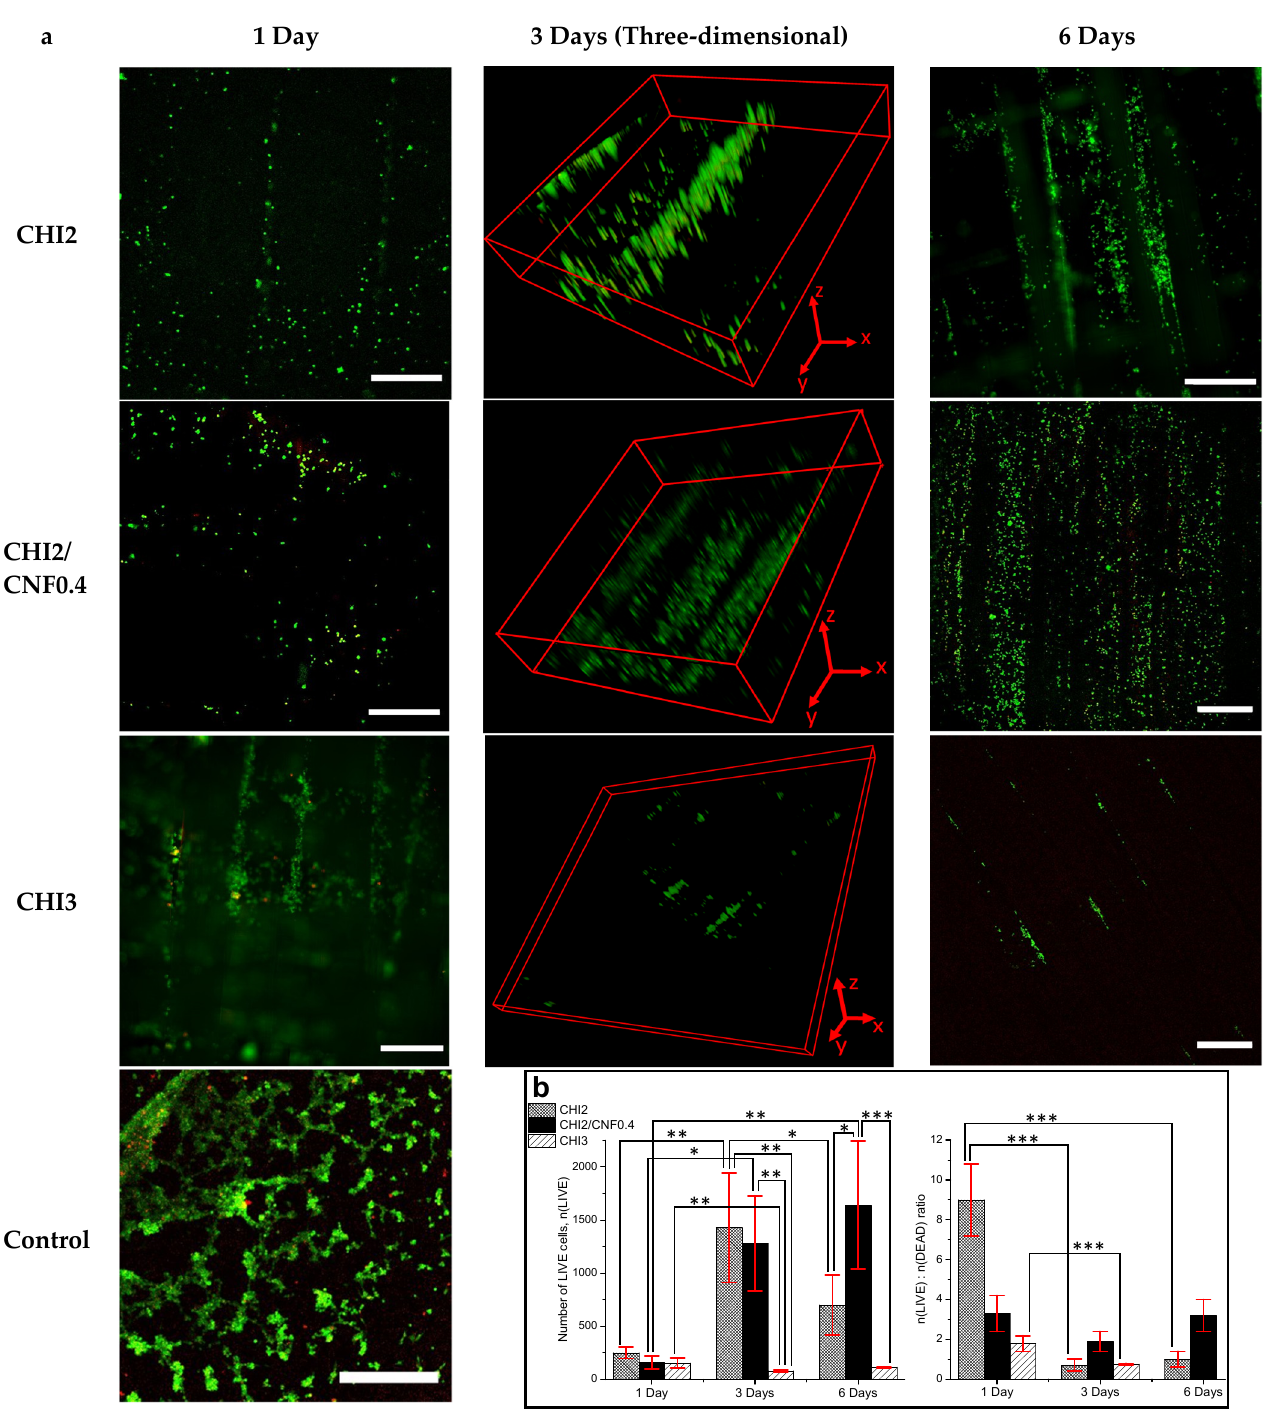
Figure 9. ( a ) LIVE/DEAD assay confocal laser scanning microscopy (CLSM) images after culture of NIH/3T3 fibroblast cells in 3D printed CHI/CNF hydrogel composite scaffolds of different CHI and CNF concentrations (Figure 8). LIVE indicator: green fluorescence; DEAD indicator: red fluorescence. Scale bars: 500 μ m. Three-dimensional frames (3 days) scale: CHI2) x*y*z: 2.3*2.3*0.075 mm 3 ; CHI2/CNF0.4) x*y*z: 2.3*2.3*0.50 mm 3 ; CHI3) x*y*z: 3.0*3.0*0.15 mm 3 . ( b ) (Left) Number of LIVE cells n (LIVE); ( Right ) n (LIVE)/ n (DEAD) cell ratio obtained for the different CHI/CNF formulations at the different days, expressed as means ± SDs, n = 4 (* p < .05, ** p < .01, *** p < .001).